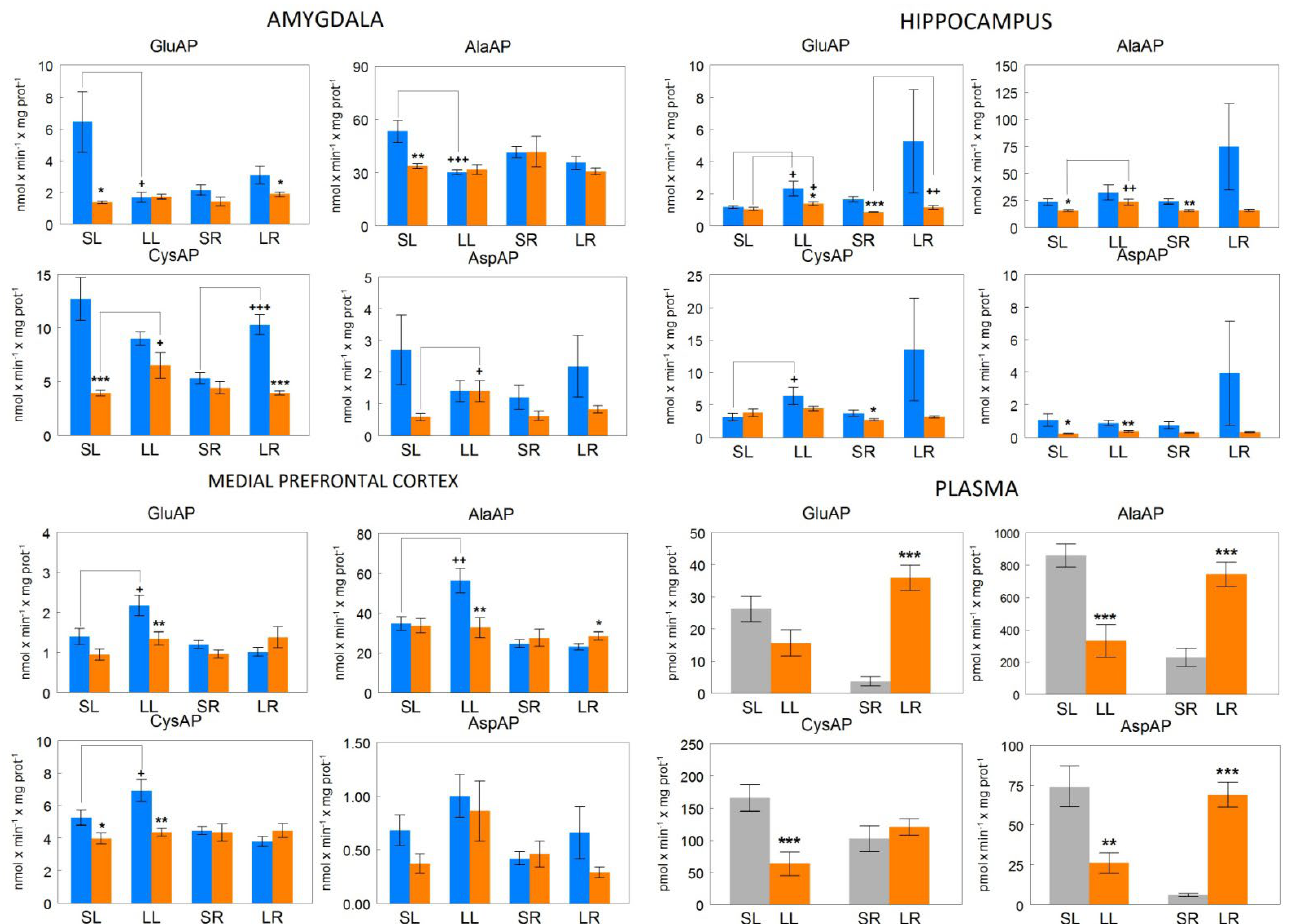
Figure 3. Glutamyl- (GluAP), alanyl- (AlaAP), cystinyl- (CysAP) and aspartyl- (AspAP) aminopep- tidase activities, in their membrane-bound forms, expressed as nmol of L-Glu- β -naphthylamide, L-Ala- β -naphthylamide, L-Cys- β -naphthylamide and L-Asp- β -naphthylamide hydrolyzed per min per mg of proteins in the left (blue bars) or right (rose bars) side of the amygdala, hippocampus, medial prefrontal cortex and as pmol of the same substrates hydrolyzed per min, per mg of proteins in plasma of sham left (SL) or sham right (SR) and lesioned left (LL) or lesioned right (LR) adult male spontaneously hypertensive rats. In plasma, gray bars represent sham groups (SL, SR) and rose bars represent lesioned groups (LL, LR). Each group represents the mean ± SEM values for 10 animals. Asterisks (*) indicate the level of statistical significance between the left and right side of the brain or between sham vs. lesioned animals in plasma. Crosses (+) indicate statistical difference on the same side, between sham vs. lesioned rats. Single (*/+) ( p < 0.05), double (**/++) ( p < 0.01) or triple symbol (***/+++) ( p < 0.001). Preliminary partial data of AlaAP from mPFC [49], CysAP from mPFC [50] and GluAP from plasma [46] and mPFC [45] were previously